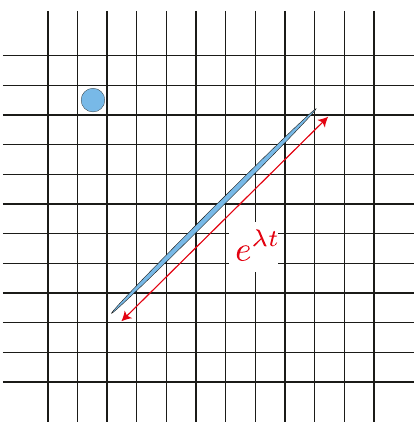
Figure 1 . Suppose we know that the initial condition is contained in the blue disk in the upper left corner. As this region evolves with time, although the volume is conserved due to the Liou- ville theorem, the shape changes nontrivially, in particular, it is stretched exponentially in several directions. The rate is governed by the positive Lyapunov